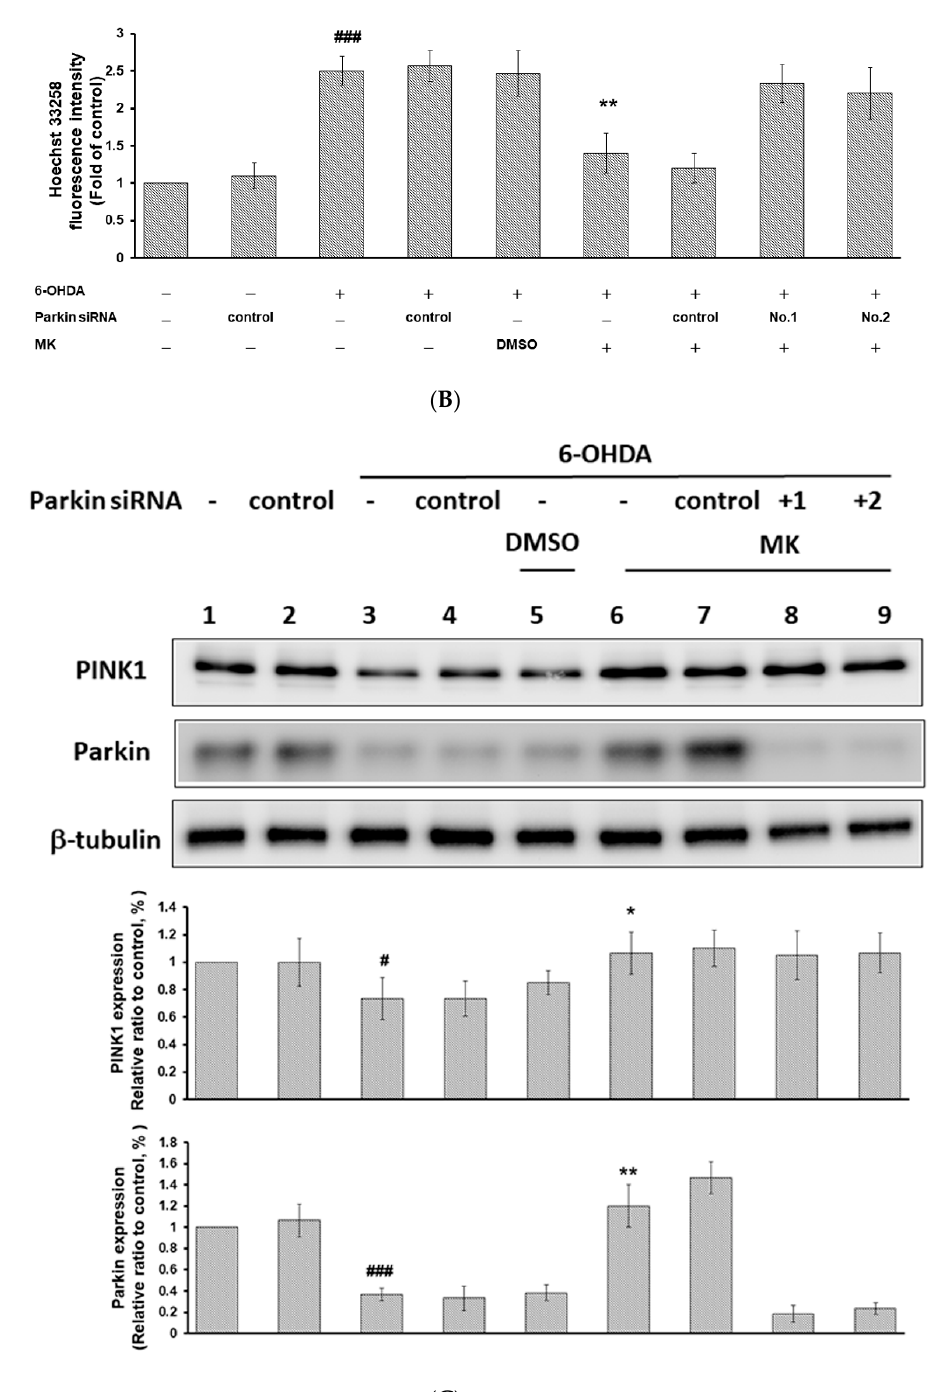
Figure 9. Parkin ‐ siRNA reversed the anti ‐ apoptotic effect of maackiain (MK) in the 6 ‐ hydroxydopamine (6 ‐ OHDA) ‐ exposed SH ‐ SY5Y cell line. SH ‐ SY5Y cells were transfected with control siRNA or parkin ‐ siRNA for 24 h. Transfected cells were incubated with 1 µM MK for 24 h and then exposed to 100 µM 6 ‐ OHDA for 18 h. ( A ) The loss in mitochondrial membrane potential (MMP) was observed by using DiOC6 dye (1 µM). Top, representative phase contrast images and fluorescent images; bottom, the fluorescence intensity of DiOC6 was analyzed by using ImageJ. The relative fold fluorescence intensity is represented as the ratio relative to the control experiment. ( B ) Nuclear condensation was observed by using Hoechst 33258 staining. Top, representative phase contrast images and fluorescent